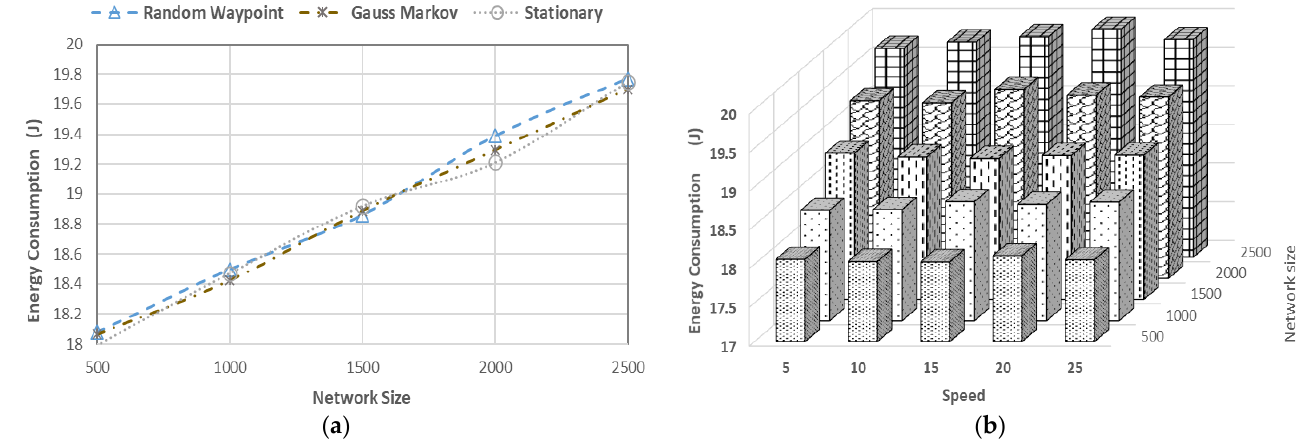
Figure 8. Energy consumption: ( a ) average energy consumption per end device for a network with 1000 × 1000 area, 20 B payload, and 5 m/s speed across different network sizes; ( b ) average energy consumption per end device for a network with 1000 × 1000 area using the Gauss – Markov mobility model, with 20 B payload for different speeds in m/s.